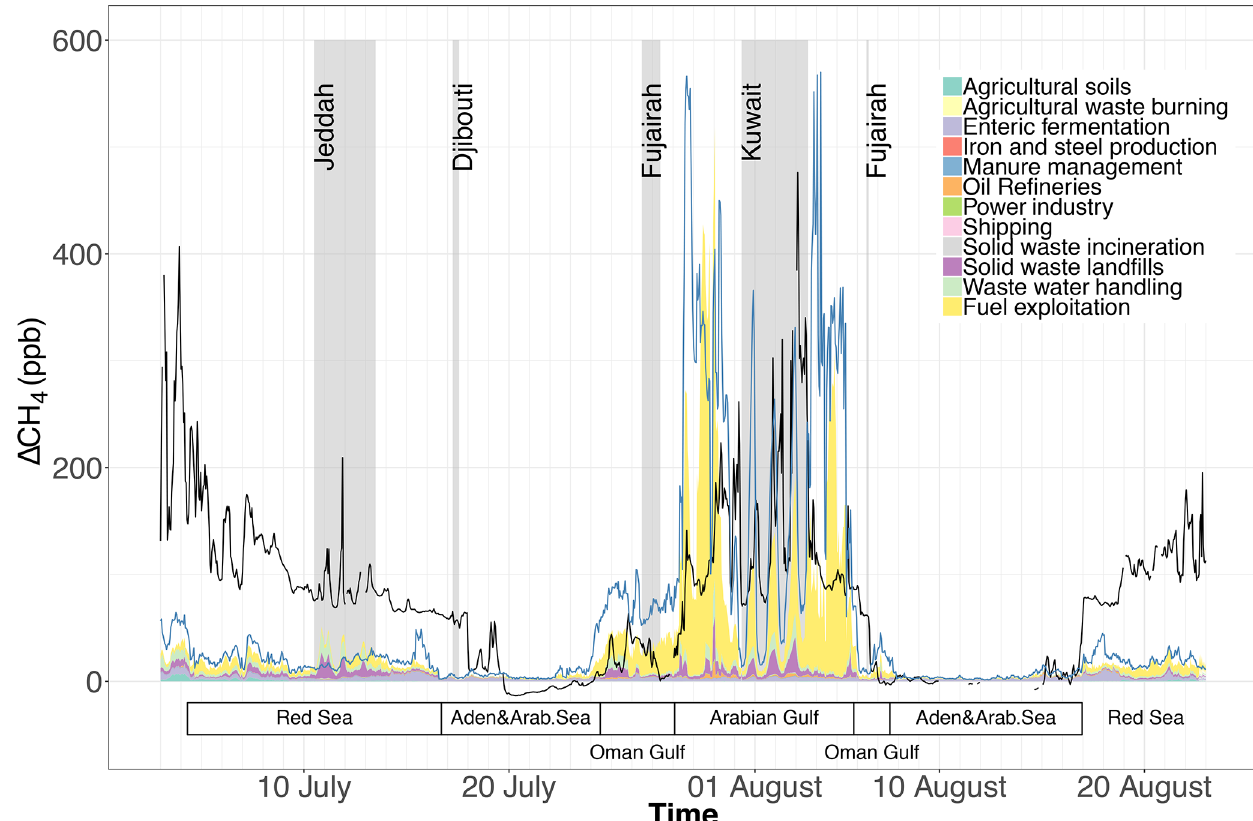
Figure 8. Comparison of simulated excess CH 4 time series at the receptor position and hourly average (cid:49) CH 4 measured from the ship (black line). All data at harbors are included. The simulation combines FLEXPART potential emission sensitivity and EDGAR inventory (stacked areas). The main source sectors are indicated using a color code. The potential emission sensitivity is also combined with the ECLIPSE inventory for comparison (blue line). The stops at each harbor are indicated as shaded gray areas, with the names of the harbors indicated at the